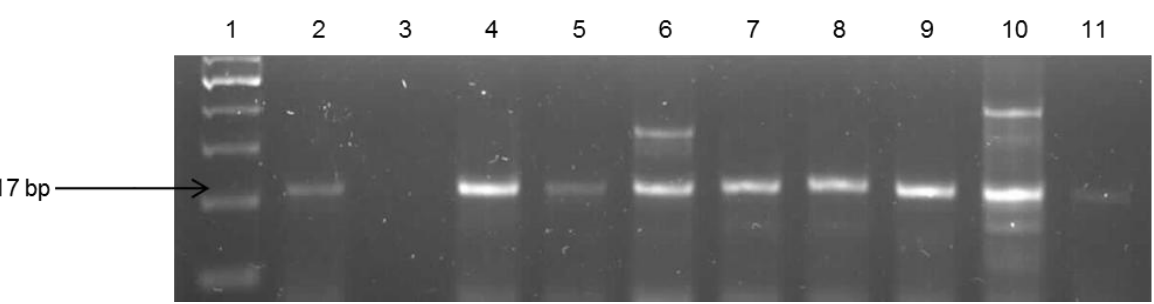
Figure 5. Gel electrophoresis of PCR products of some of the confirmed V. vulnificus . Lane 1: Gene ruler (100 bp); Lane 2: Positive (+ve) control V. vulnificus (410 bp); Lane 3 (Negative control); Lane 4–13